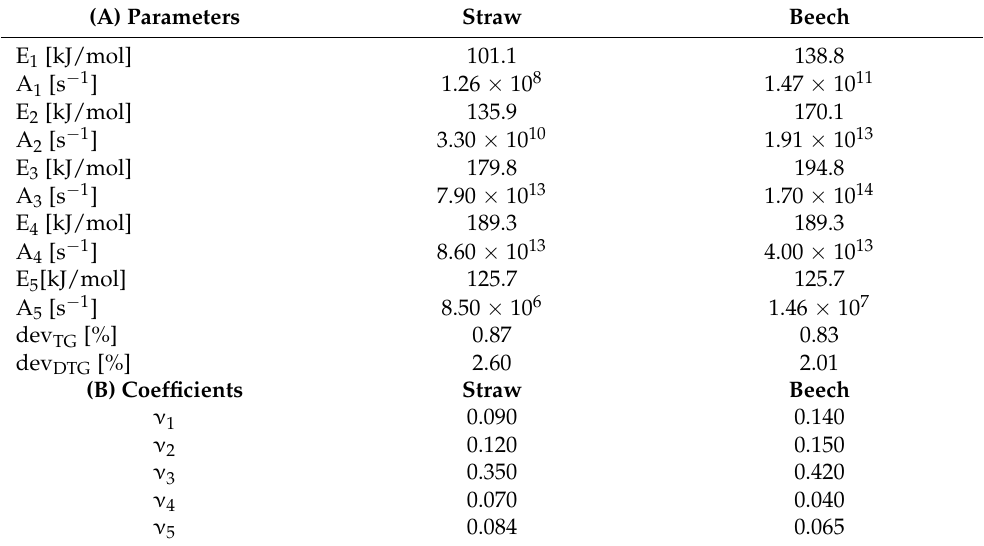
Table 2. Estimated kinetic parameters (activation energy E i and pre-exponential factor A i (A) and stoichiometric coefficients ν i (B)) for wheat straw and beech wood [22]: components n.1,2 for pseudo- hemicellulose, including extractives, component n.3 for pseudo-cellulose, and components n.4,5 for pseudo-lignin; and corresponding deviations between measured and simulated integral (dev TG ) and differential (dev DTG ) curves